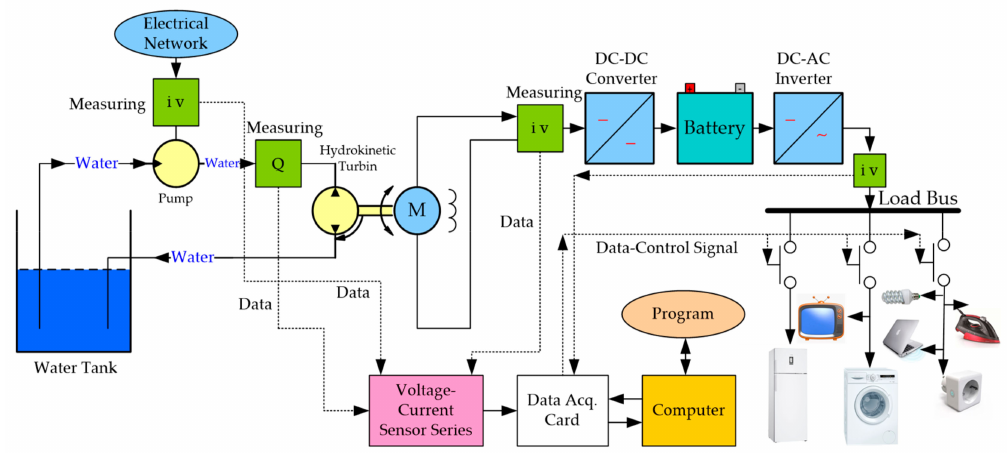
Figure 1. Principle view of hydrokinetic energy conversion